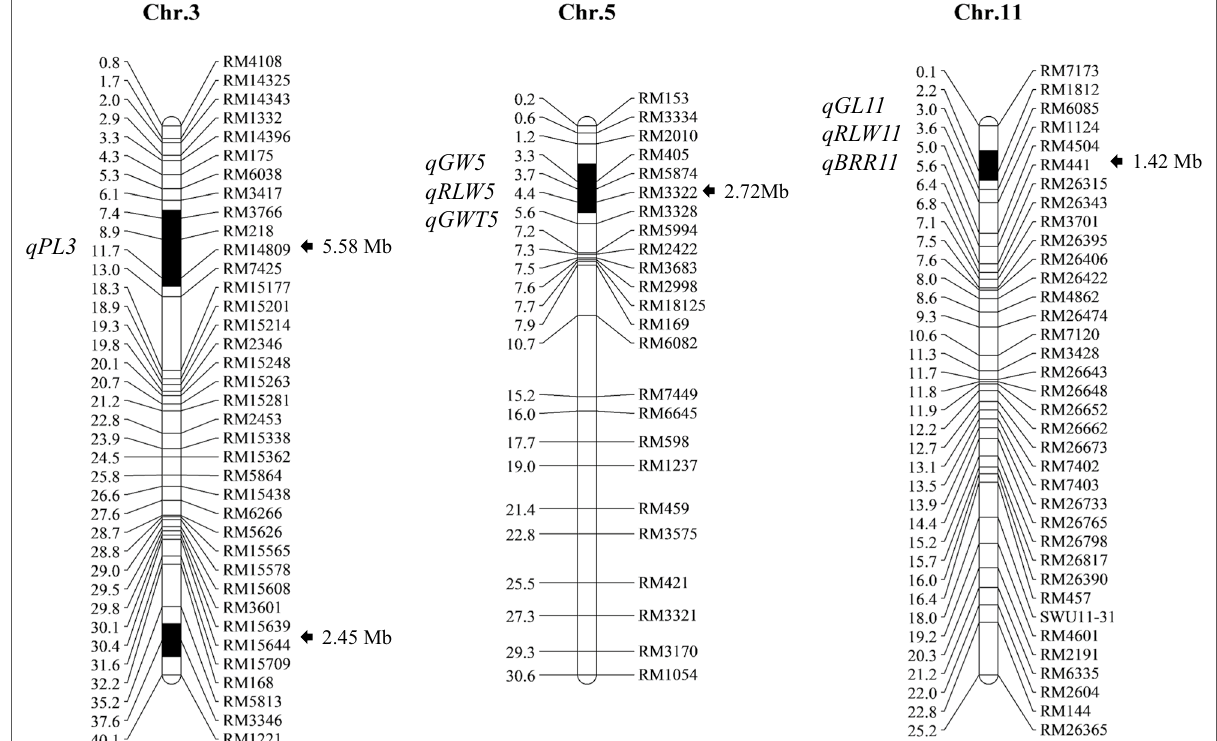
Fig. 1 Chromosome substitution segments of Z414. Physical distances (Mb) and mapped QTL are indicated on the left; markers and substitution segment lengths are shown on the right. The black sections on each chromosome are substitution segments. PL, panicle length; GW, grain width; GL, grain length; RLW, ratio of length to width; GWT, 1000-grain weight; BRR, brown rice